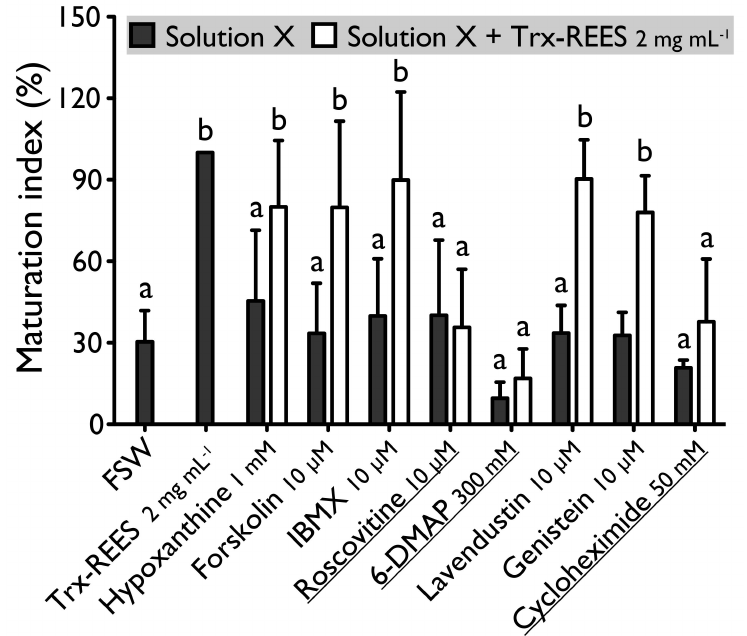
Figure 3. Effect of hypoxanthine (1 mM), forskolin (10 µ M), IBMX (10 µ M), roscovitine (10 µ M), 6-DMAP (300 mM), lavendustin (10 µ M), genistein (10 µ M) and cycloheximide (50 mM) on H. tubulosa oocyte maturation, induced by Trx-REES. Values are means of Maturation Index ± SD ( n = 3 individ- uals). Columns surmounted by sign ( a ) or ( b ) are significantly similar to control (SW or Trx-REES) surmounted with the same sign (P Dunnett ≥ 0.05). For underlined solutions, the indices of maturation were not significantly different with or without Trx-REES (P t -test ≥